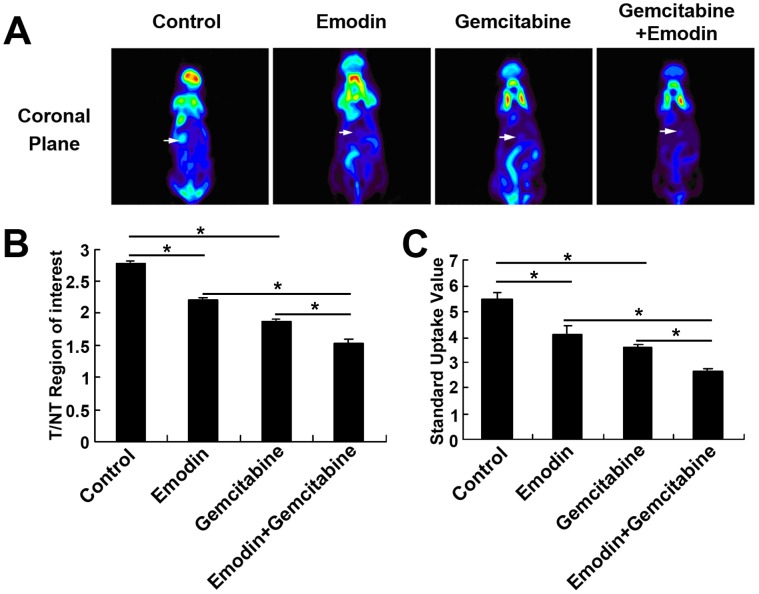
Panc-1 cells were used to establish an orthotopic pancreatic carcinoma xenograft animal model.(A) MicroPET showing a large coronal sectional orthotopic transplantation tumor of a nude mouse. (B and C) T/NT ratio and SUVs in the gemcitabine group, the emodin group and the combination group were lower than that of the control group (0.9% sodium chloride) (P<0.05), and the combination group showed even lower T/NT ratio and SUVs than the emodin group and the gemcitabine group. *, P<0.05.